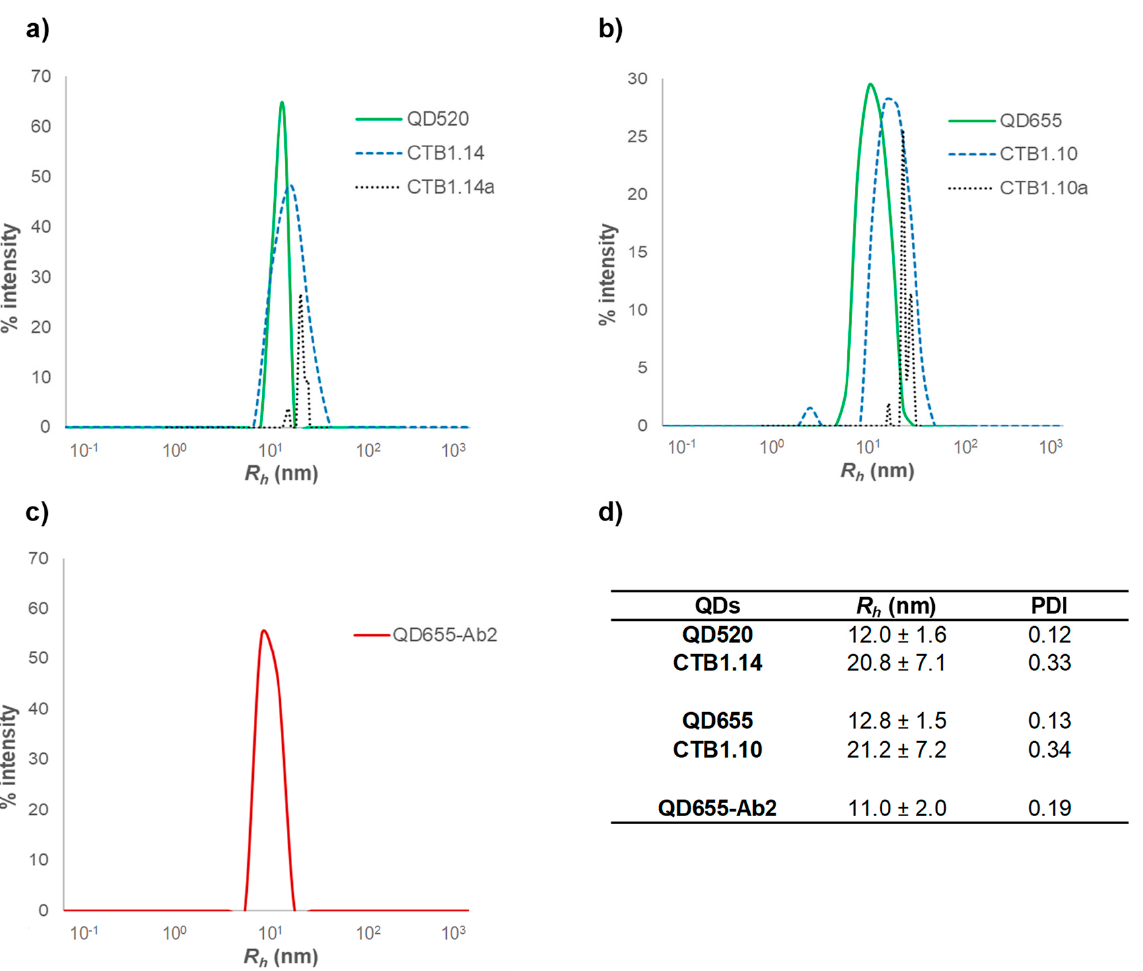
Figure 3. Size distribution of QDs, QD bioconjugates and QD-Ab2 obtained by DLS. ( a ) QD520 from Sigma-Aldrich, its protein A conjugate CTB1.14 and TDP-43 antibody conjugate CTB1.14a. ( b ) QD655 from Invitrogen, its protein A conjugate CTB1.10a and TDP-43 antibody conjugate CTB1.10a. ( c ) QD655-Ab2 from Invitrogen. ( d ) R h and PDI of QDs